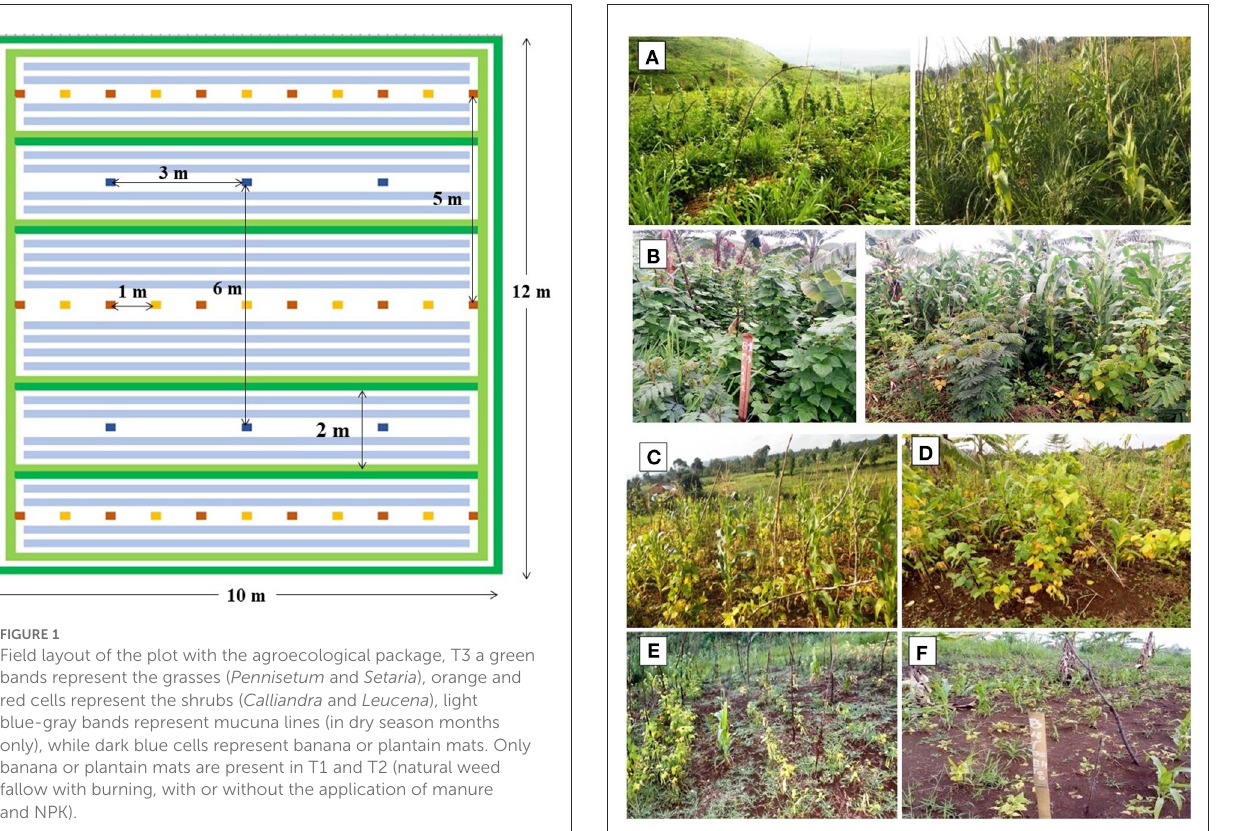
FIGURE2 T3: The field with the modified agroecological package during the first year (A) and the 4th year (B) after trial establishment in Mulungu, T2: burn practices with NPK and manure application during the first year (C) and 4th year (D) and T1: burn practices without NPK and manure application during the first year (E) and 4th year (F)